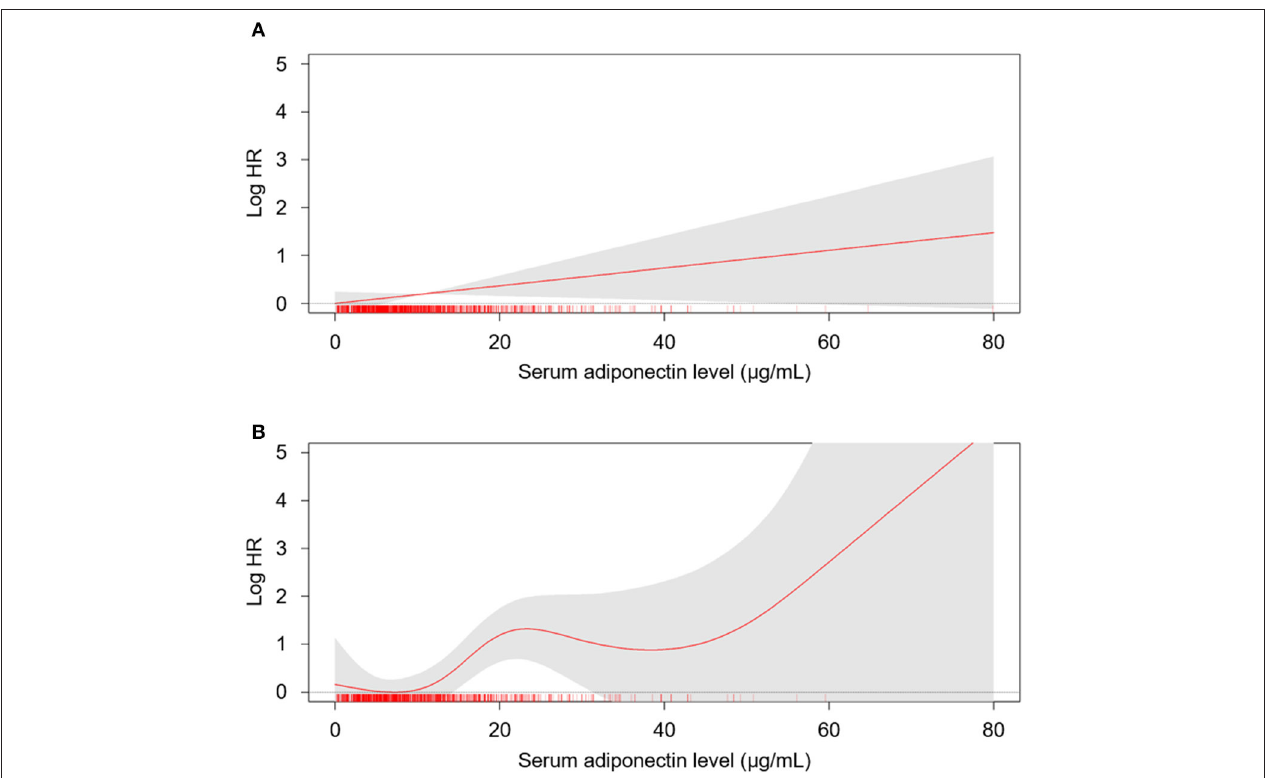
FIGURE 2 | The restricted cubic spline of serum adiponectin on the risk of fatal and non-fatal CV events. Crude (A) and adjusted (B) HRs of serum adiponectin as a continuous variable for fatal and non-fatal CV events are depicted. The model was adjusted for age, gender, Charlson comorbidity index, history of DM, smoking history, BMI, WC, SBP, DBP, medications (ACEi/ARBs, statins, diuretics), hemoglobin, albumin, HDL-C, fasting glucose, hs-CRP, eGFR, 24-h urine protein, and categorized CACS at the baseline. HR, hazard ratio; CV, cardiovascular; CACS, coronary artery calcium score eGFR, estimated glomerular filtration rate; DM, diabetes mellitus; BMI, body mass index; WC, weight circumference; SBP, systolic blood pressure; DBP, diastolic blood pressure; HDL, high density